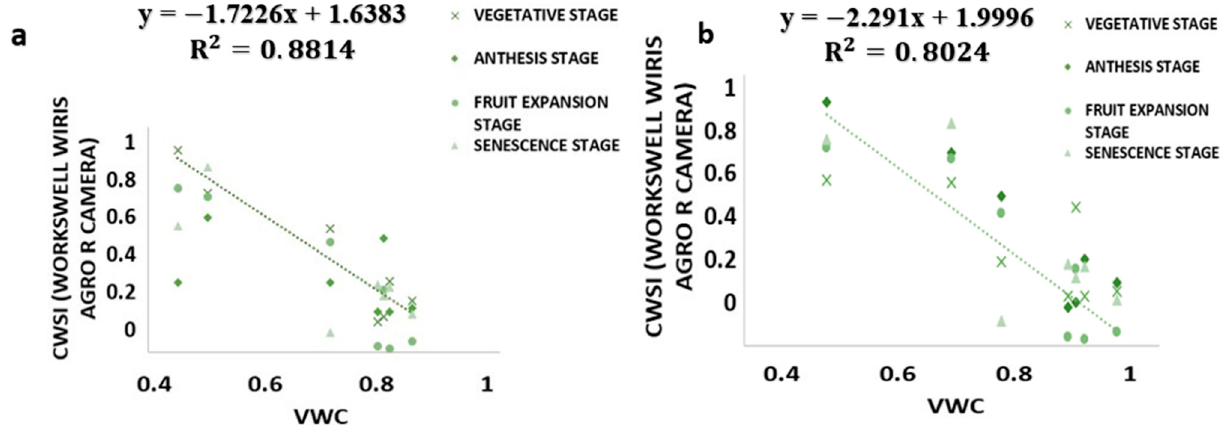
Figure 10. Correlation between the CWSI W and VWC: ( a ) sandy loam soil and ( b ) silt loam soil.